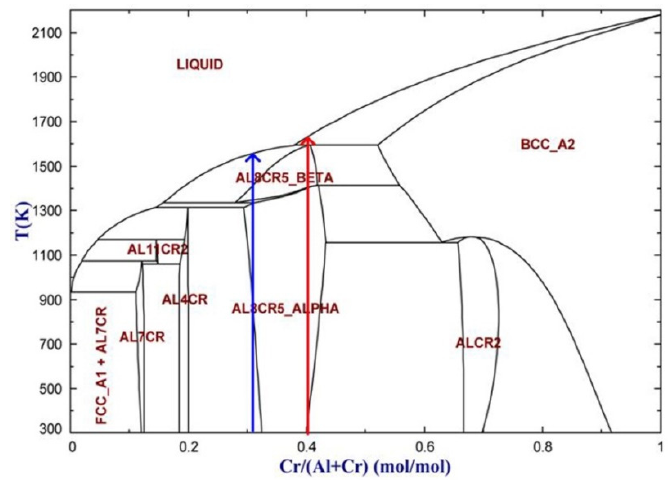
Figure 6. Cr-Al phase diagram from FactSage 7.3 databases [32].